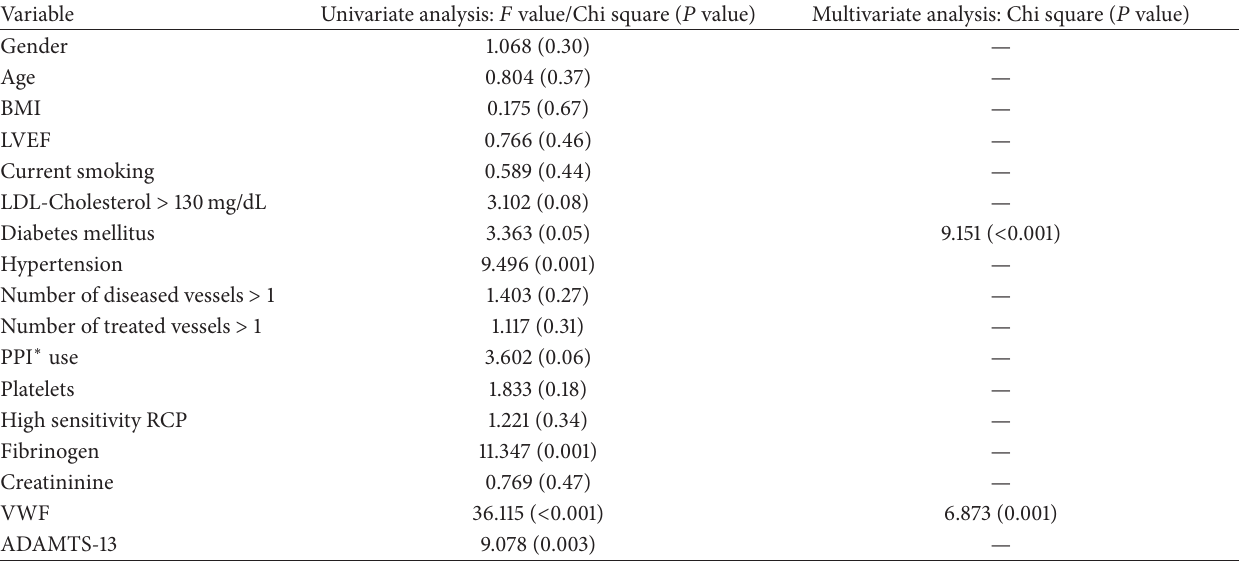
Table 3: Multivariate logistic regression for association with HPR (CEPI-CT < 190sec) at T